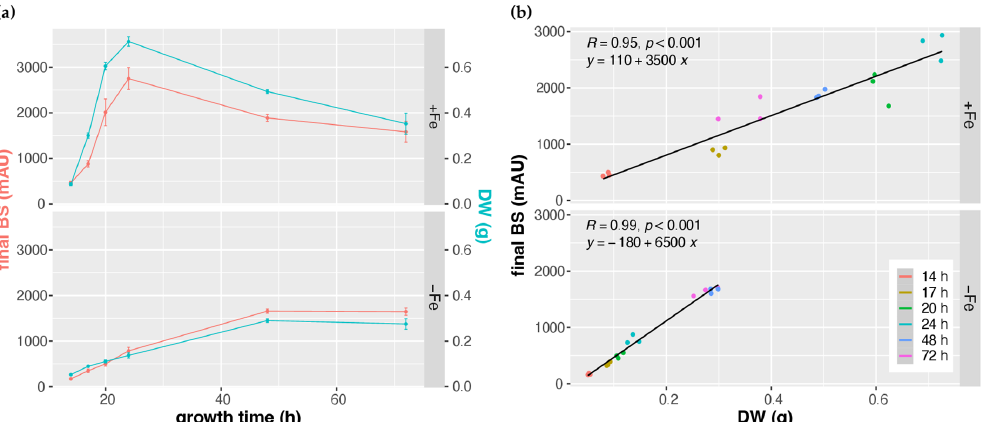
Figure 4. Positive correlation of CGQ-mediated growth monitoring and classical biomass measure- ment of A. fumigatus AfS77 during 14–72 h liquid shake culturing under +Fe and − Fe conditions. Data were taken from the experiments described in Figure 2 and Table 1 . ( a ) Time course graphs of mean final backscatter (final BS) and mean dry-weight (DW) ± standard deviation of 3 runs each. ( b ) Final BS plotted vs. DW with colored dots representing endpoints of individual cultures grown for the times indicated. Pearson correlation coefficient and corresponding p -values are displayed in the upper left side of the panels. Regression lines and corresponding equations based on linear models fitted to the scatter plots are